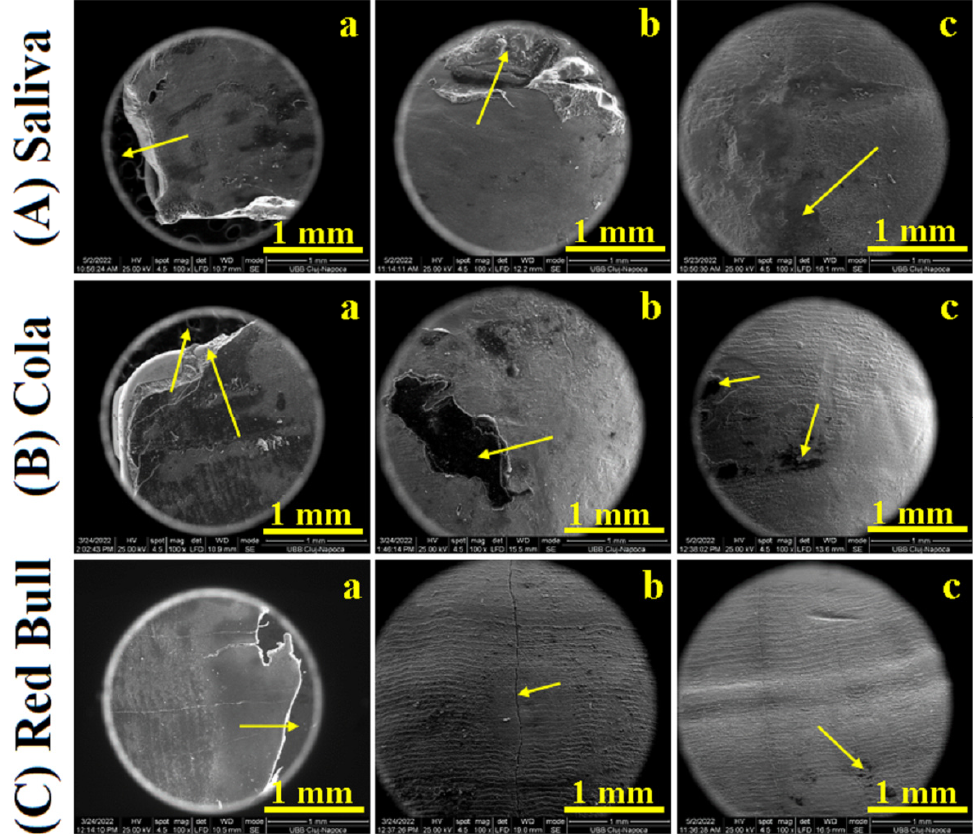
Figure 1. SEM images of CR samples: ( a ) bracket after debonding, ( b ) enamel after debonding, and ( c ) debonded enamel after polishing; stored in Saliva ( A ), exposed to Cola ( B ) and exposed to Red Bull TM ( C ).